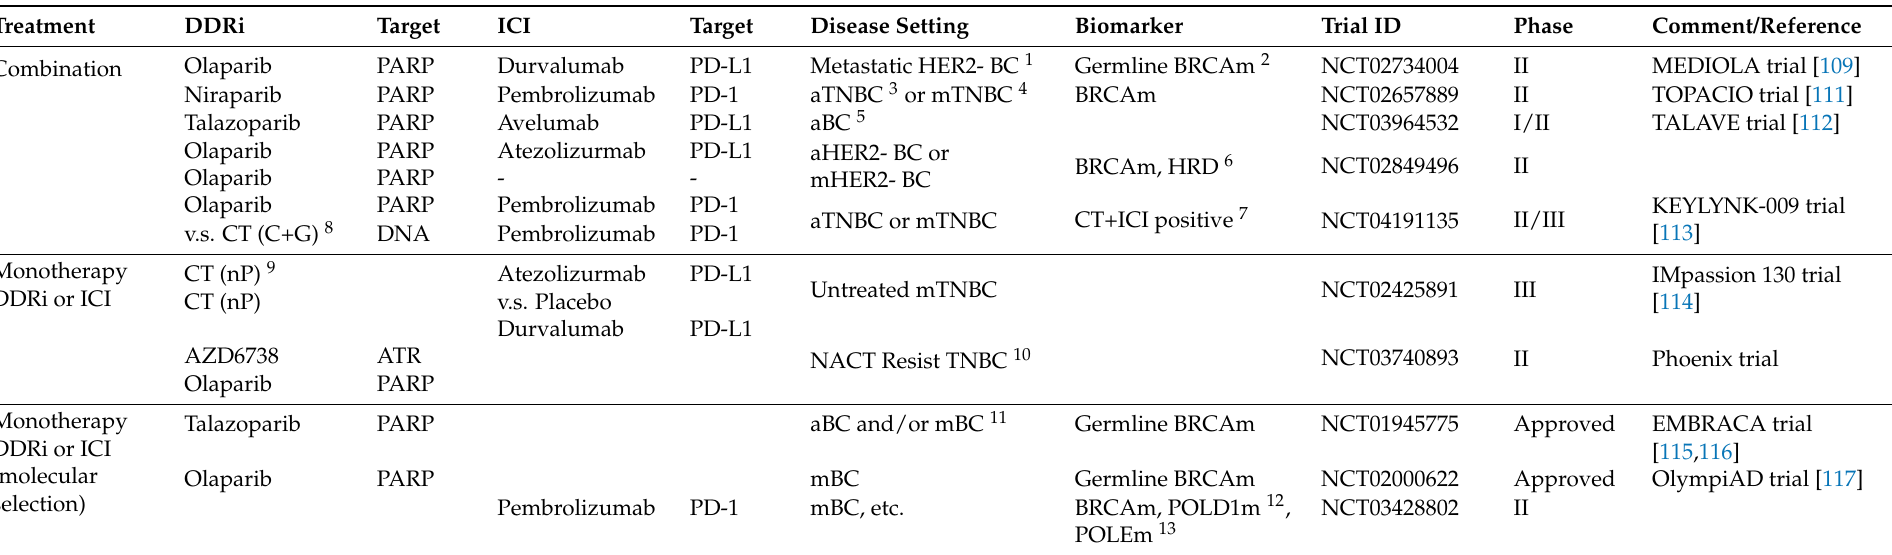
Table 1. Clinical trials of breast cancer using immunotherapy or synthetic lethality